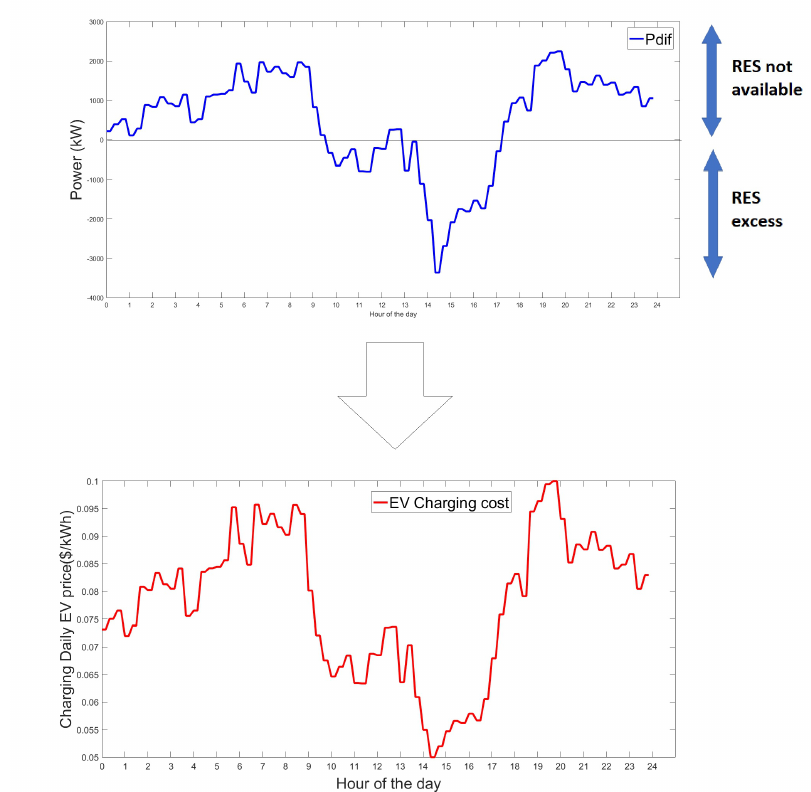
Figure 1. Difference of residential load and RES power, and EV charging specific